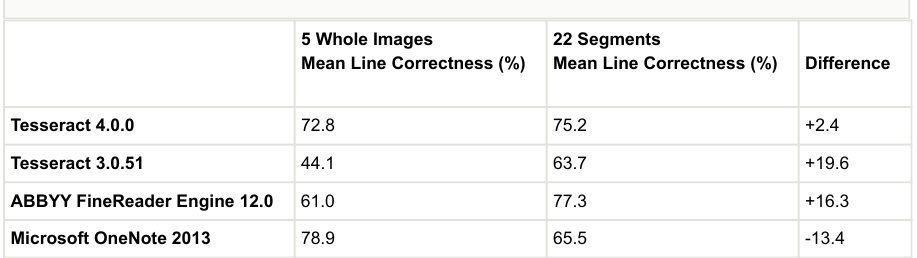
Table 5. Line correctness for OCR using whole images and their